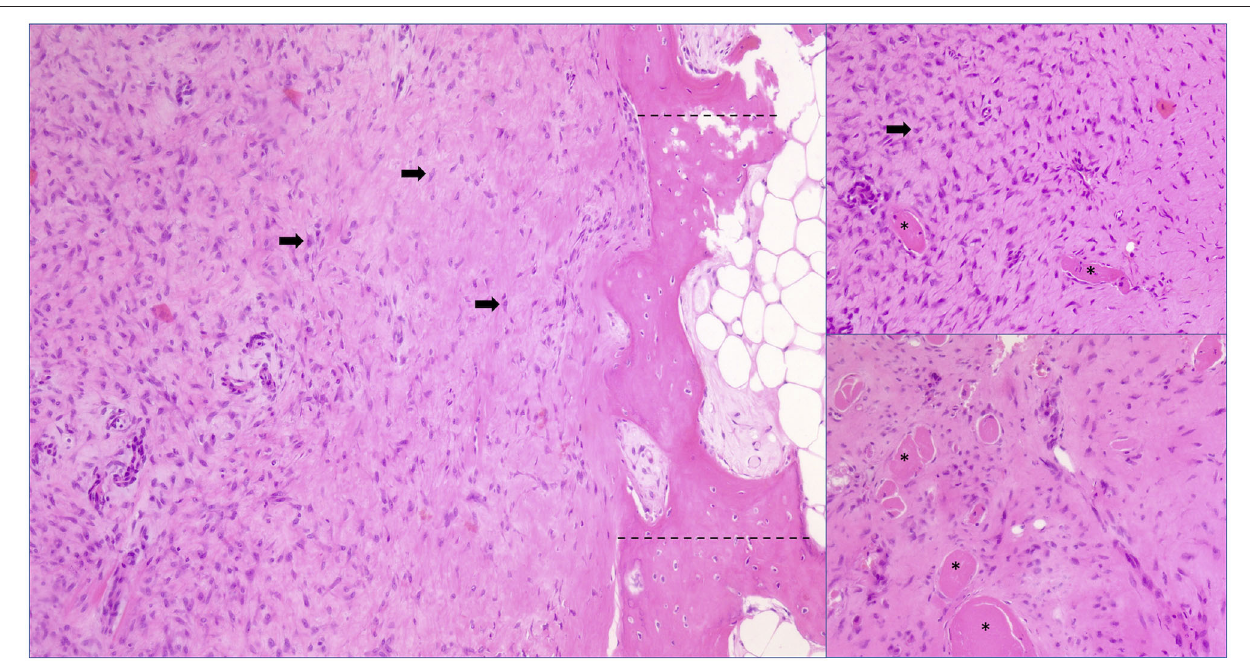
FIGURE 2 | Histopathology-biopsy of affected lumbar muscles, hematoxylin and eosin (HE) stain, magnification 100 x. Extensive proliferation of fibroblasts (black arrows) encasing multiple myofibers (asterisks) accompanied by marked myofiber diameter variations and boarding well-differentiated bony trabeculae (between dotted lines). Cell atypia and inflammation are